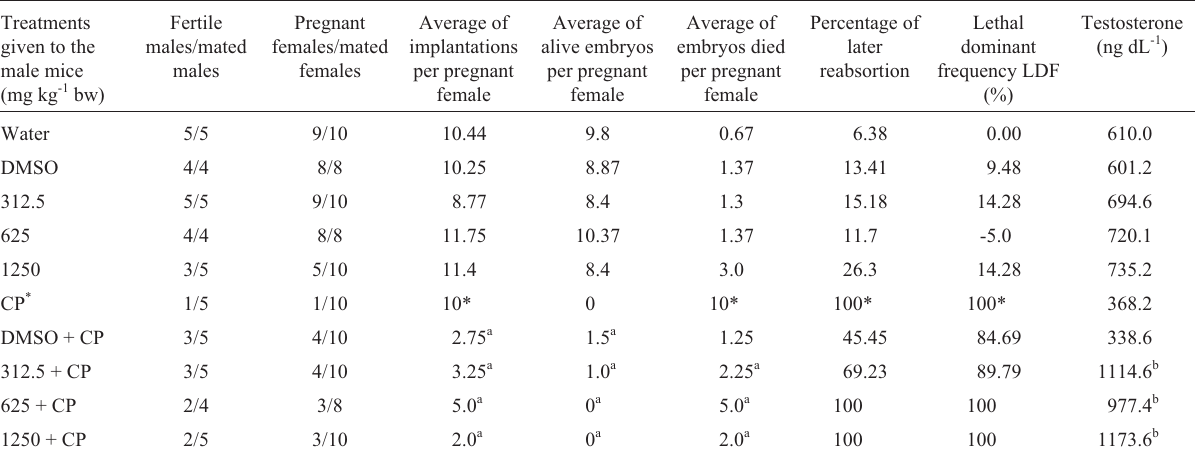
Table 2 - Lethal Dominant Assay and testosterone concentration in Swiss albino mice submitted to sub-chronic treatment with the methanol extract of Croton cajucara for the assessment of mutagenicity and antimutagenicity. Treatments given to the male mice (mg kg -1